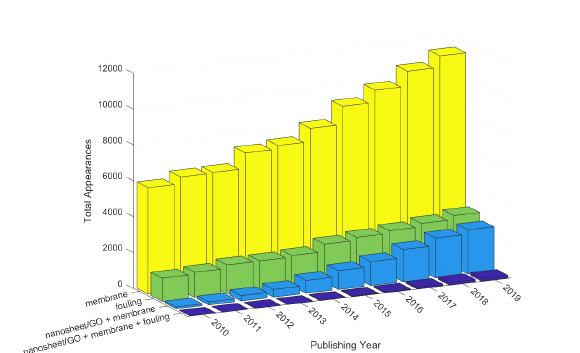
Figure 1. Increasing interest in antifouling two-dimensional (2D) nanocomposite membranes; results were obtained from the “Web of